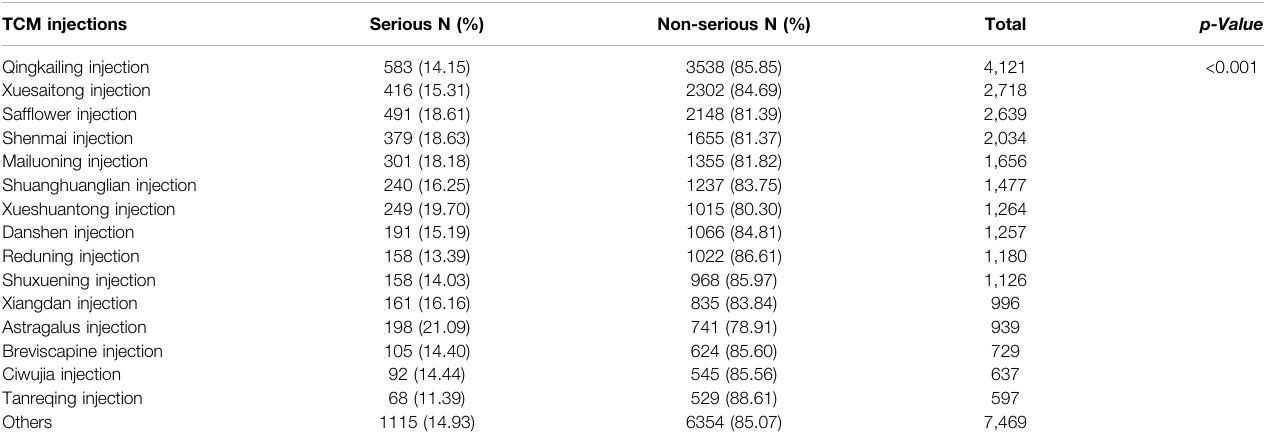
TABLE 2 | Number and proportion of serious and non-serious reports by TCM injections. TCM